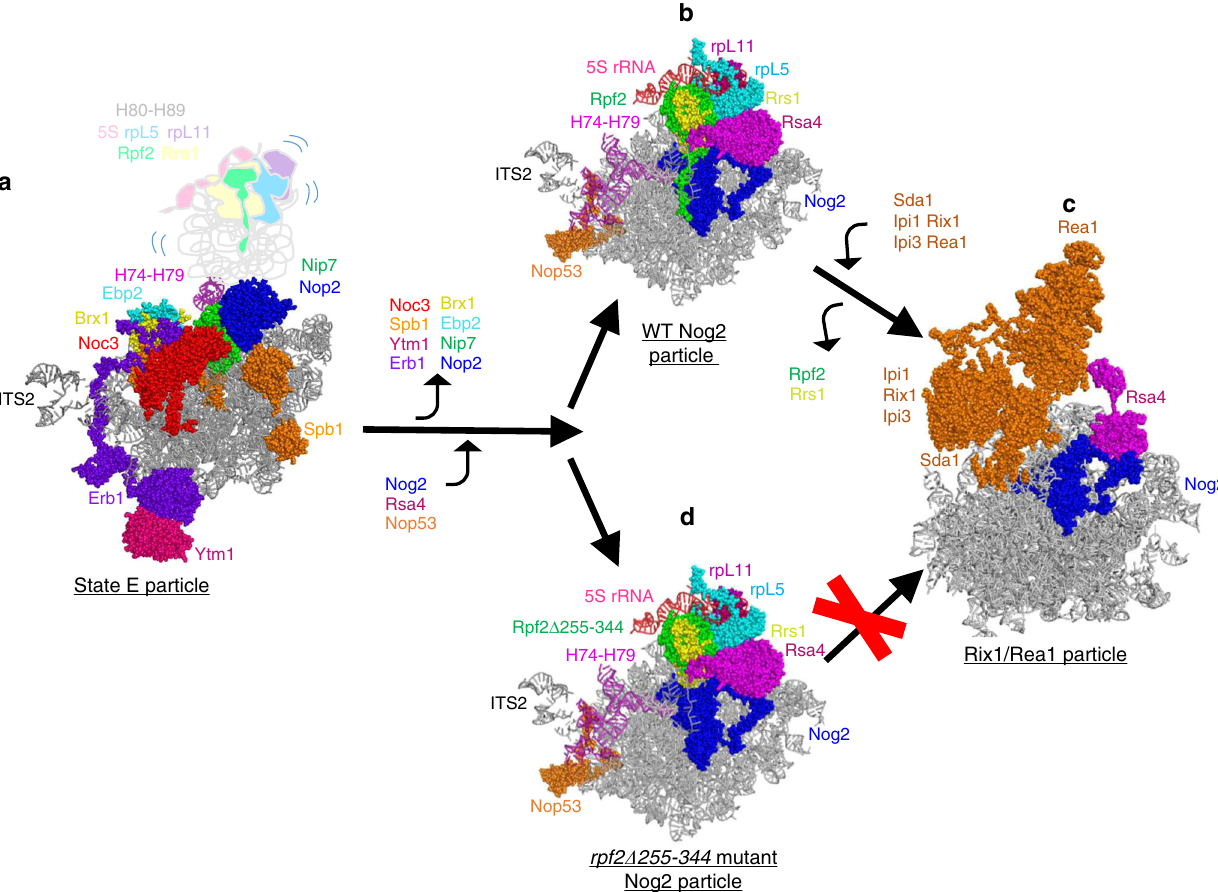
Fig. 10 The CTD of Rpf2 is necessary as Nog2 particles transition to Rix1/Rea1 particles. a The 25S rRNA domain V and the Rpf2 subcomplex are in a fl exible state and thus invisible (represented as the group in light colors) prior to rearrangements within the State E particle, including exit of labeled AFs from state E particles. b Stable anchoring of H74-H79, conformational changes in H68-70, as well as entry of Nog2, Rsa4, and Nop53, upon formation of Nog2 particles. c The Rix1/Rea1 particle is formed upon exit of the Rpf2-Rrs1 dimer, and entry of Sda1, the Rix1 subcomplex, and Rea1, as well as 5S RNP rotation. d In the absence of the CTD of Rpf2, the transition between the Nog2 and Rix1/Rea1 particles does not occur. For simplicity and clarity, only relevant AFs are shown and colored, and all r-proteins except rpL5 and rpL11 are omitted. Only partial densities for Sda1, Rea1, and the Rix1 subcomplex are